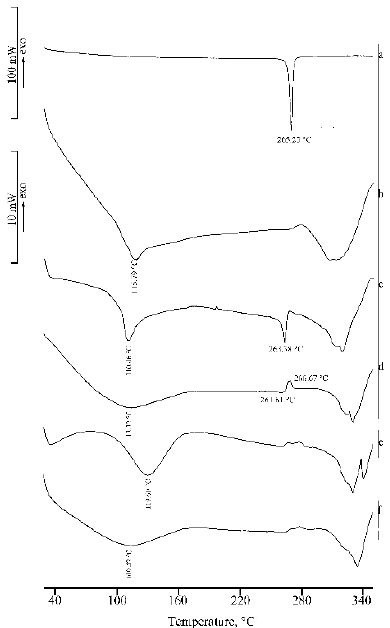
Figure 8. DSC curves of RSV ( a ), γ-CD ( b ), their PM ( c ), and products from KN ( d ), MW ( e ), and CP ( f ) treatments.